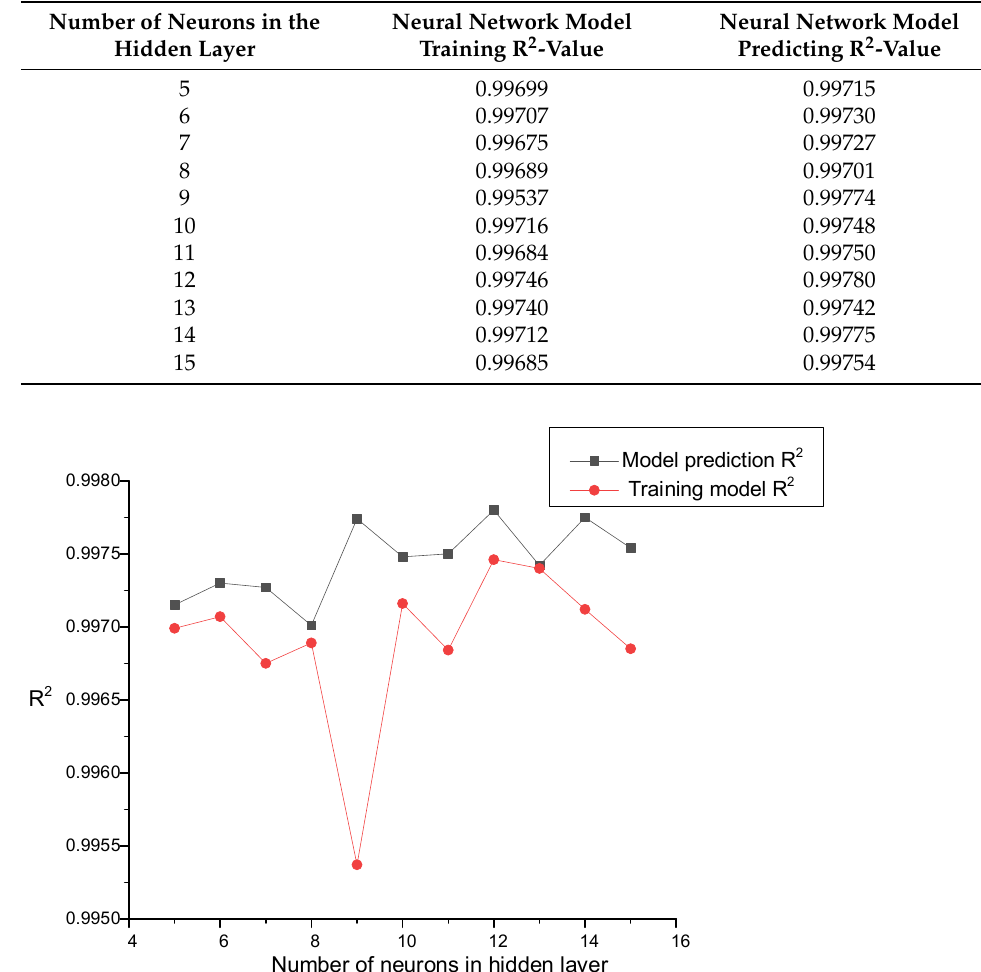
Table 4. R 2 of the model with different numbers of hidden layer neurons.